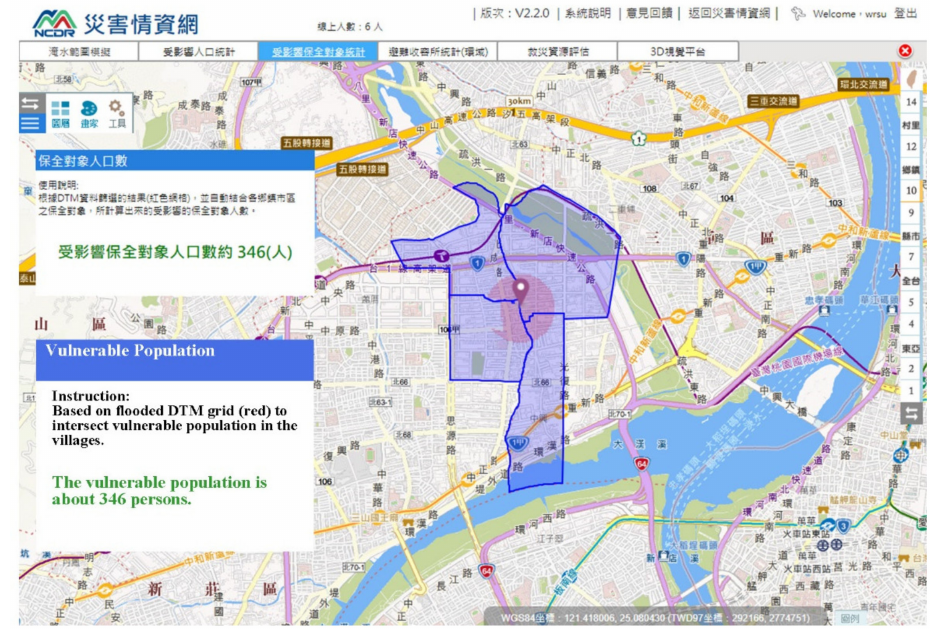
Figure 9. Tab 3: Estimating the vulnerable population (346 persons in this case